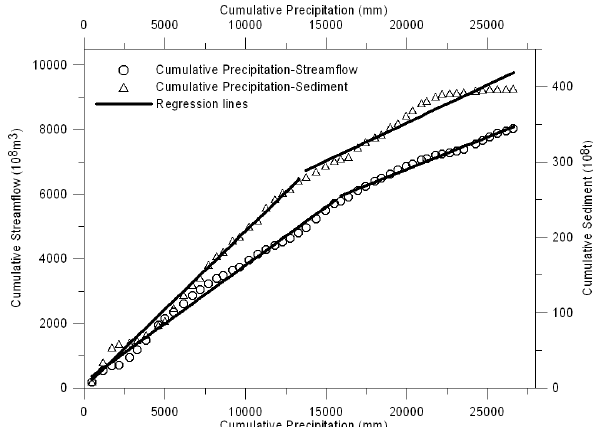
Fig. 3. Double mass curves of precipitation-streamflow and precipitation–sediment during 1957–2008 in the MRYR.